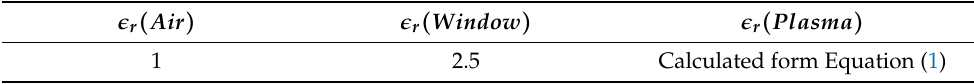
Table 3. The dielectric parameters of the air, antenna window, and